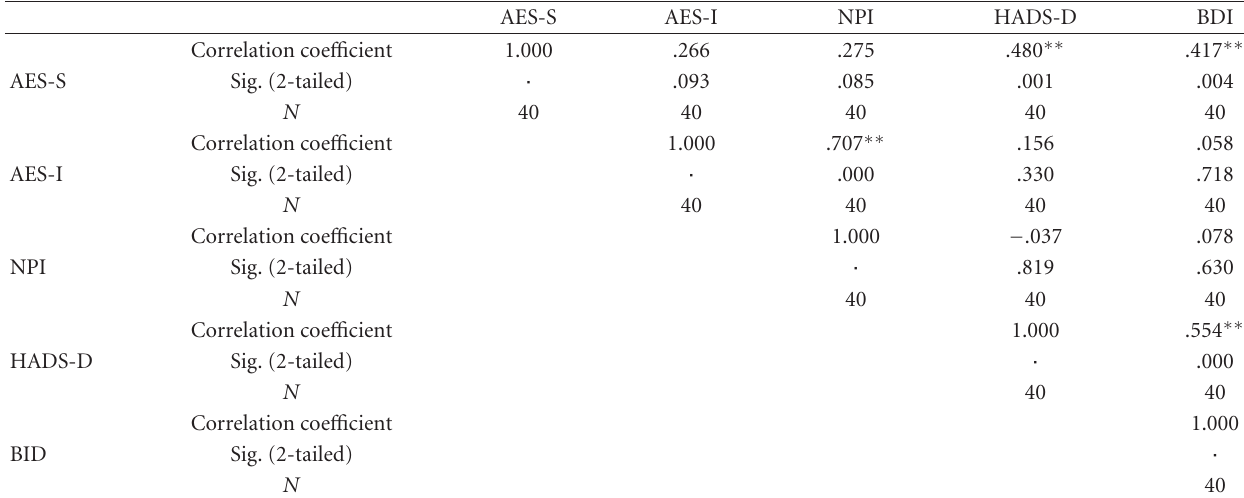
Table 2: Relationships between apathy and depression